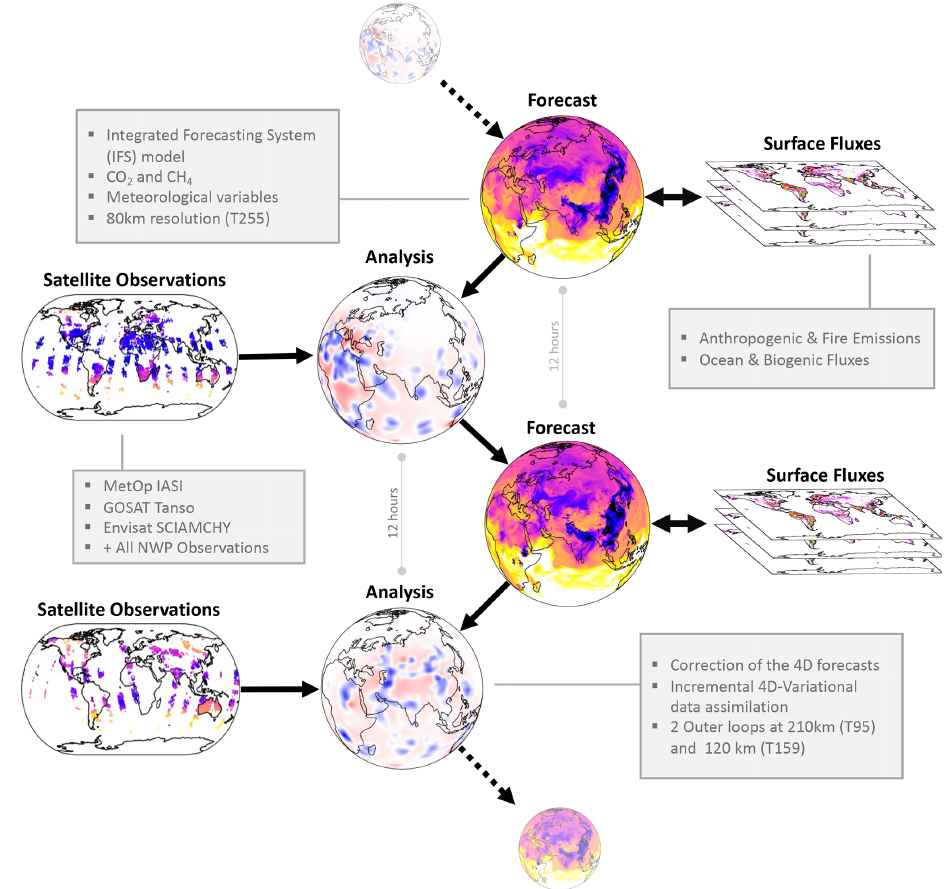
Figure 2. Schematic of the reanalysis cycling procedure. The flow diagram shows the steps and elements combined in the reanalysis. Surface fluxes are used as boundary condition for the atmospheric forecasts. Satellite data are combined with the forecast using data assimilation to produce an analysis (corrected 4D fields) to initialise the next